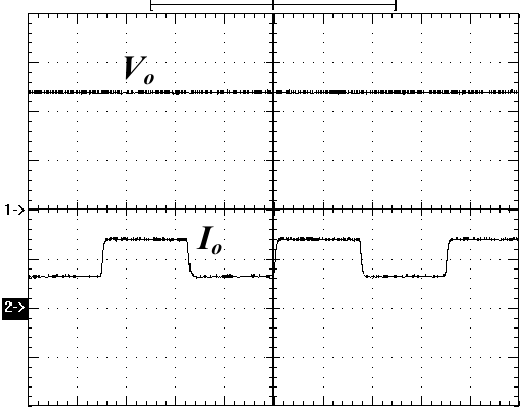
Figure 12. Experimental waveforms of V o and I o under load variation between I o = 12 and 24 A ( V o : 10 V/div; I o : 20 A/div; time: 200 μ s).